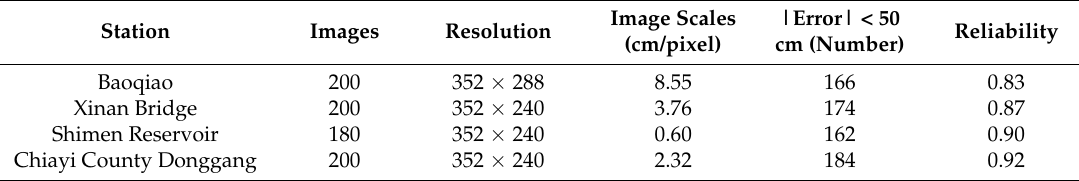
Table 1. Reliability analysis of image identification of historical data.